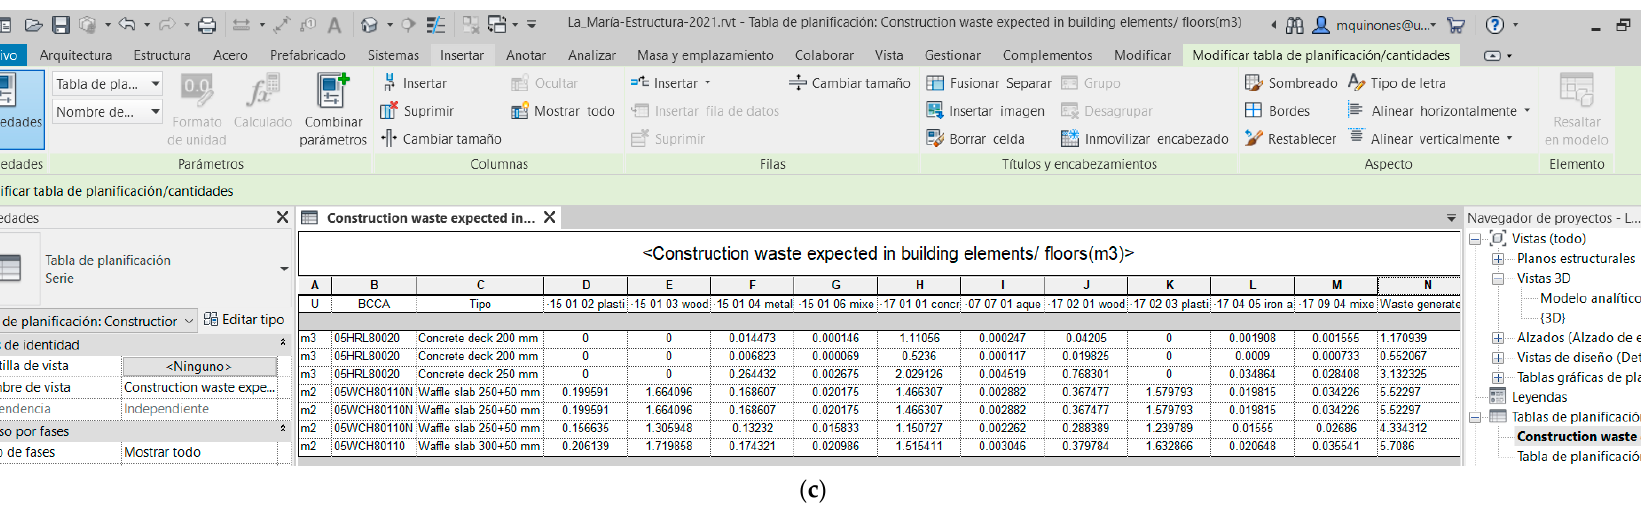
Figure 7. Examples of reports of the waste produced by the concrete slab in: ( a ) Allplan; ( b ) Archicad; ( c ) Revit.